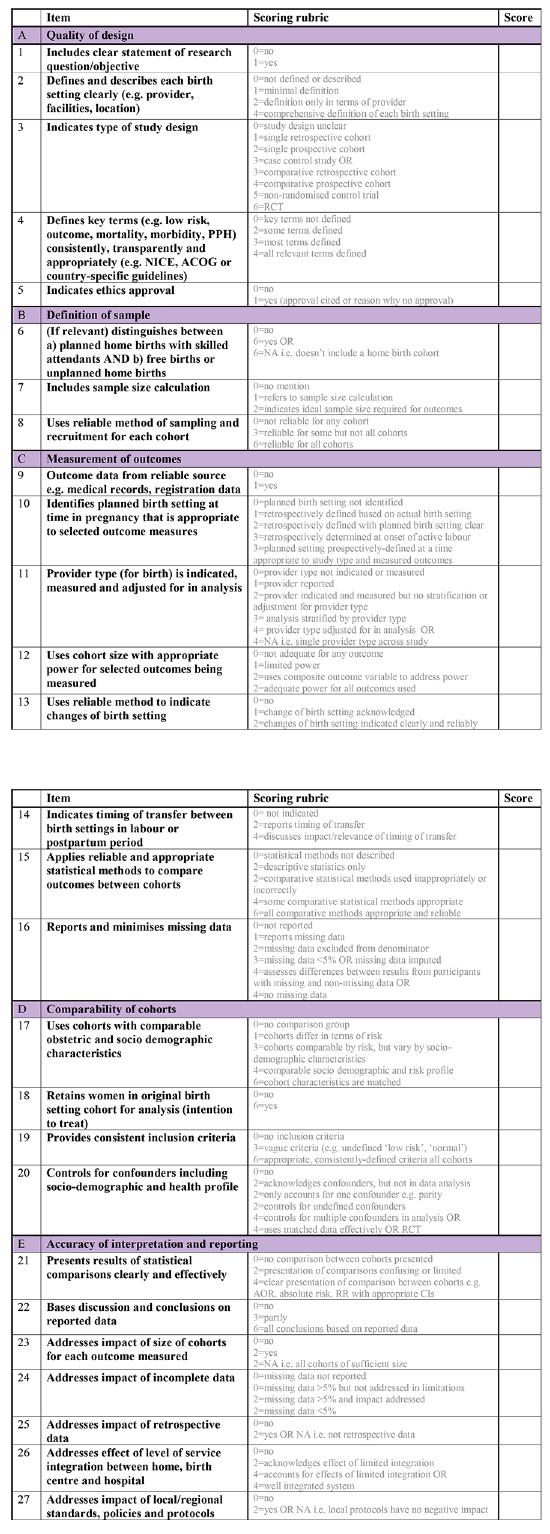
Fig 1. Birth Place ResearchQuality (ResQu) Index—Final